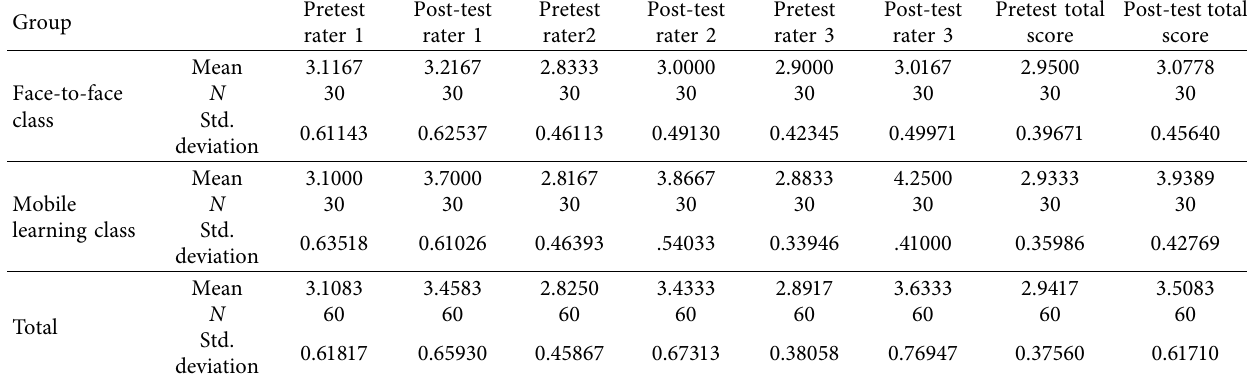
Table 1: Distribution of the two groups’ mean scores in pretest and post-test.